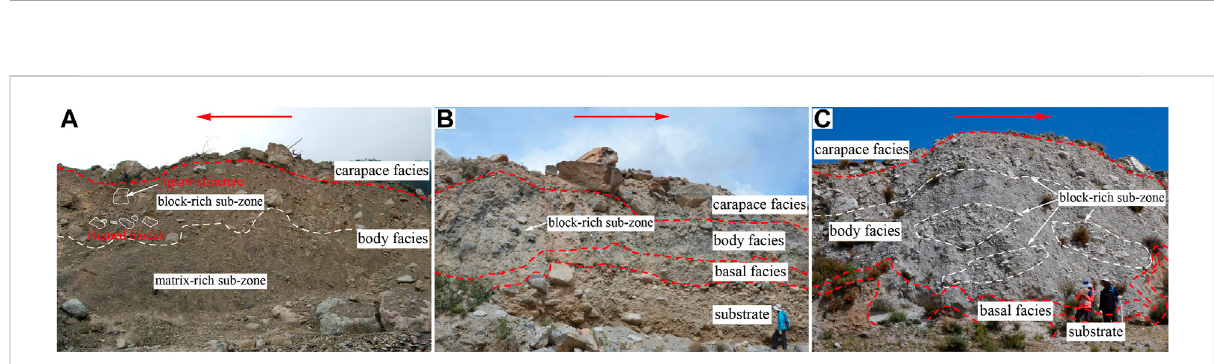
FIGURE 6 Depositedpro fi lesoftheXiejiadianzi (A) ,Tagarma (B) ,andNyixoiChongco (C) rockavalanches.Redarrowsindicatethemovementdirectionsof the avalanche